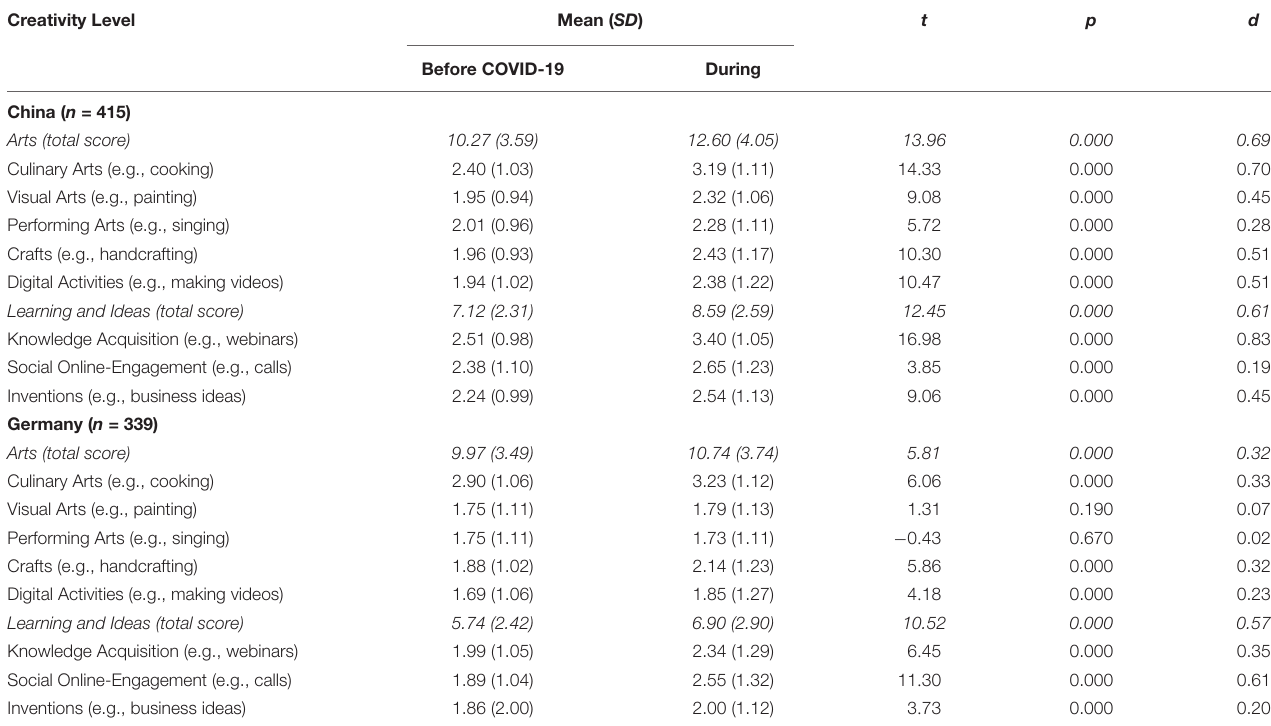
TABLE 5 | Means (standard deviations) and paired sample t -test results for the comparison between the creativity level in different domains before and during lockdown in both countries. Creativity Level Mean ( SD ) t p d Before COVID-19